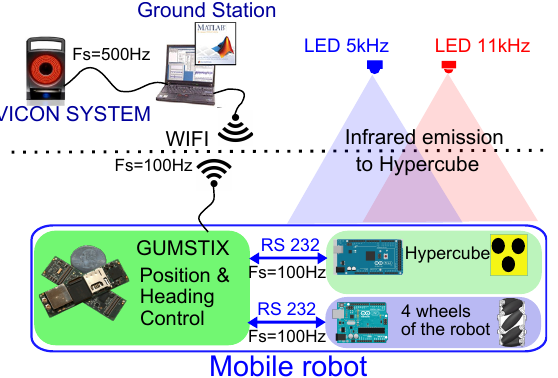
Figure 10. Sketch diagram of the implementation of the indoor localization system for mobile robots. The Arduino Mega 2560 gets the analog signals provided by the demodulation board (Arduino shield, see Figure 2) and the output voltage of each photodiode Ph i of HyperCube. The Arduino 380 board is devoted to control the angular velocity of each